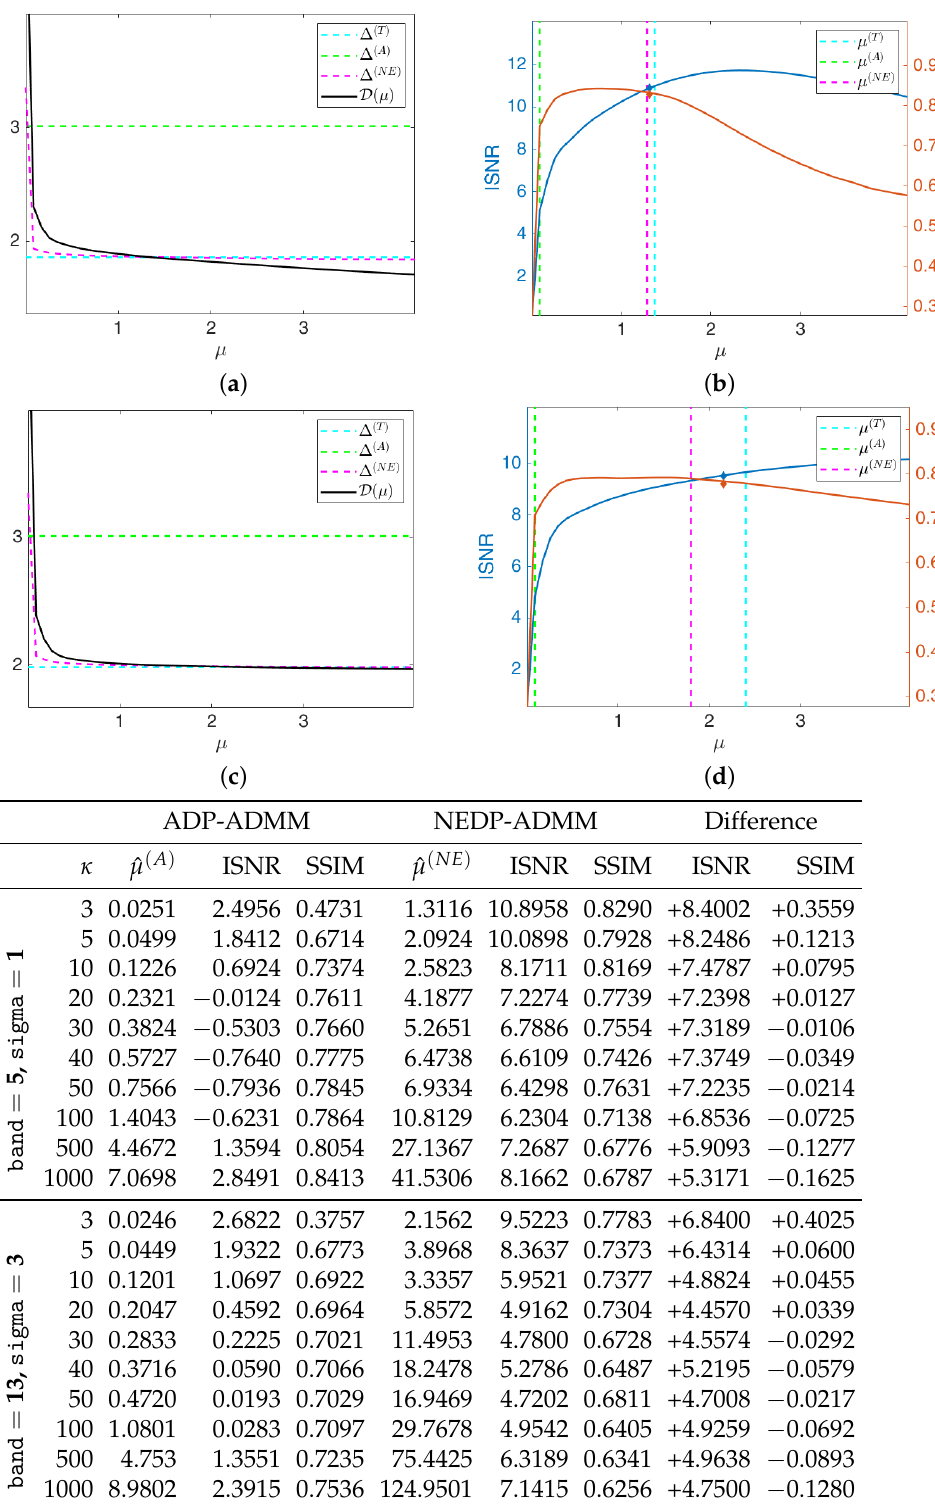
Figure 12. Test image phantom . Top : discrepancy curve divided by 10 4 ( a , c ) and ISNR/SSIM values ( b , d ) achieved for different µ -values with κ = 3 and Gaussian blur with parameters band = 5, sigma = 1 ( first row) and band = 13, sigma = 3 ( second row). Bottom : output µ -values and ISNR/SSIM values obtained by the ADP-ADMM and the NEDP-ADMM for the two blur levels considered and different photon counts κ